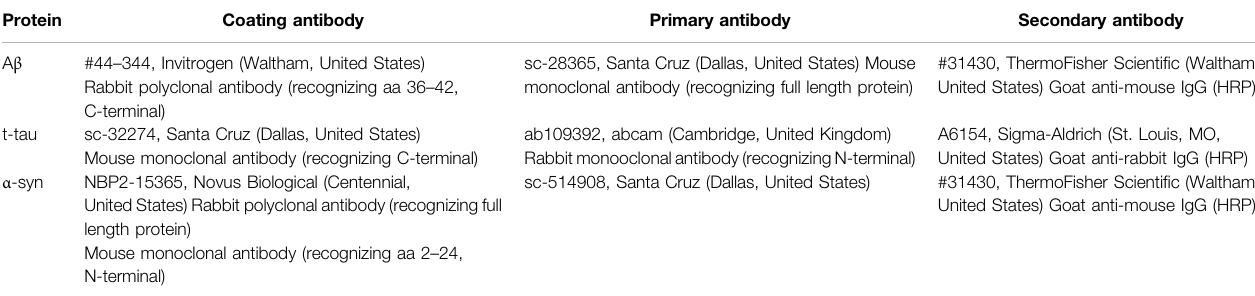
TABLE1| Antibodiesemployedinthe “ home-made ” sandwichenzyme-linkedimmunosorbentassay(ELISA).Foreachinvestigatedprotein,therespectivecoating,primary, and secondary antibodies employed for the assay are listed. The catalogue number, brand, class type antibody, and immunogen are also reported for all